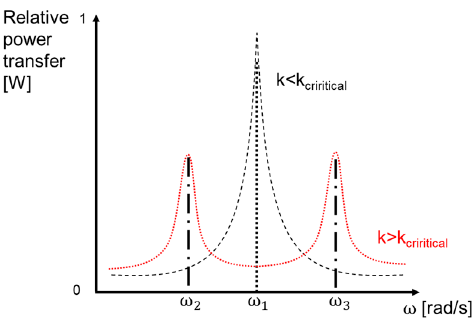
Figure 4. Schematic diagram of the transferred power to load according to the coupling coefficient and frequency.